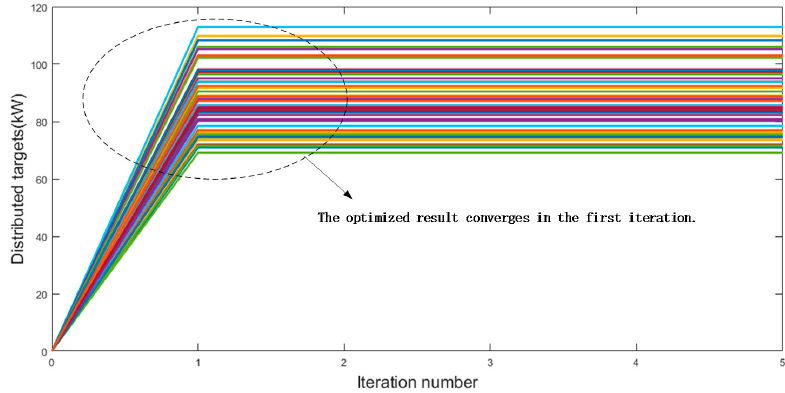
Figure 16. 60 CACs Data distribution process with the SEUMRE algorithm.